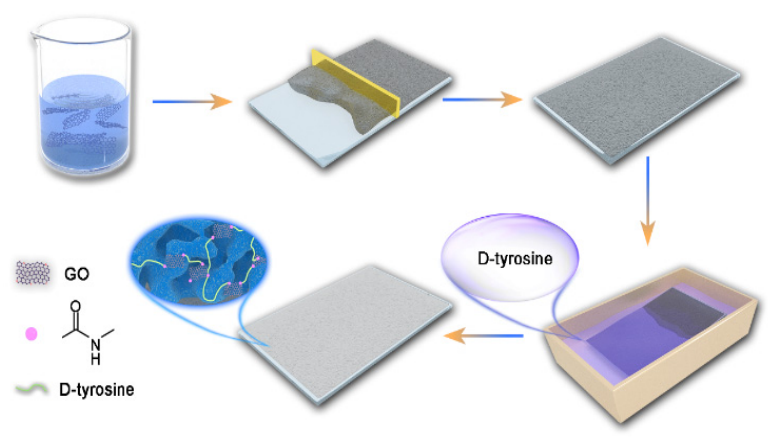
Figure 1. Synthesis schematic of membranes.